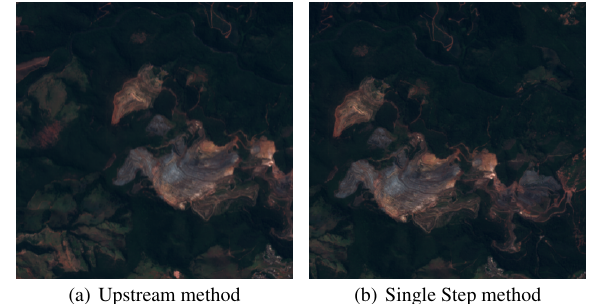
Figure 6. Examples of dams of different construction methods within the same region. Figure (a) shows a dam constructed using the Upstream method, while in a nearby region we have the image (b) of a dam constructed using the Single Step method. These sets of samples end up biasing the final classification model, which receives in its training set almost identical samples with different classes, reducing its effectiveness in the test